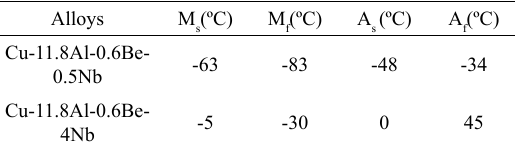
Table 1. Phase transformation temperatures for alloys.